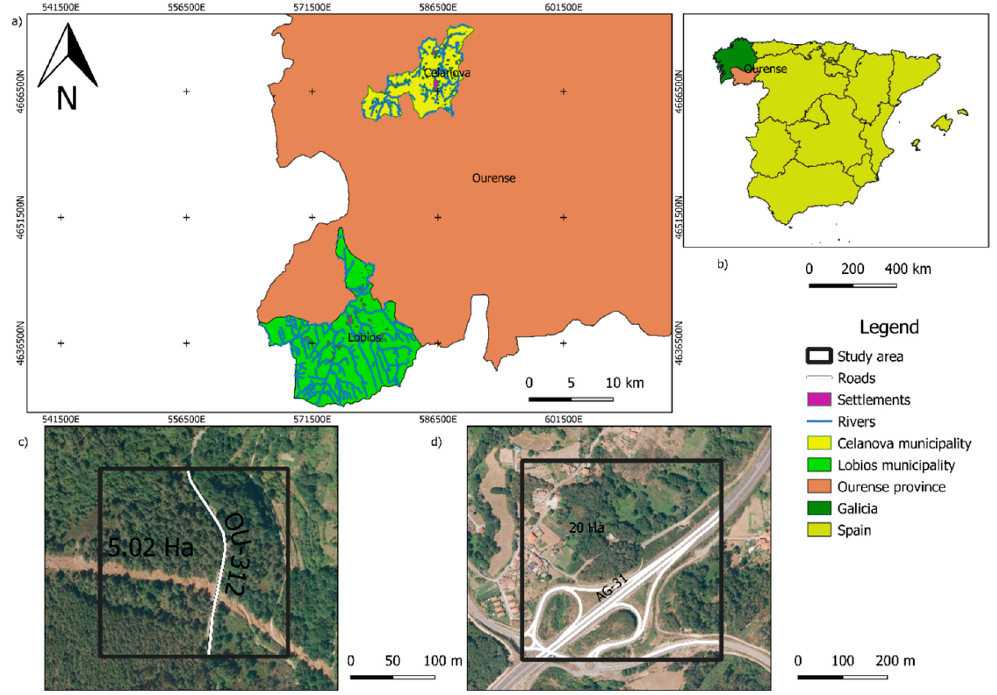
Figure 1. ( a ) Location of both study areas in Ourense province; ( b ) location of Ourense province on the Spain map; ( c ) location of study area A in Lobios municipality; ( d ) location of study area B in Celanova municipality. The map coordinate system is EPSG:25829 ETRS89/UTM zone 29N.